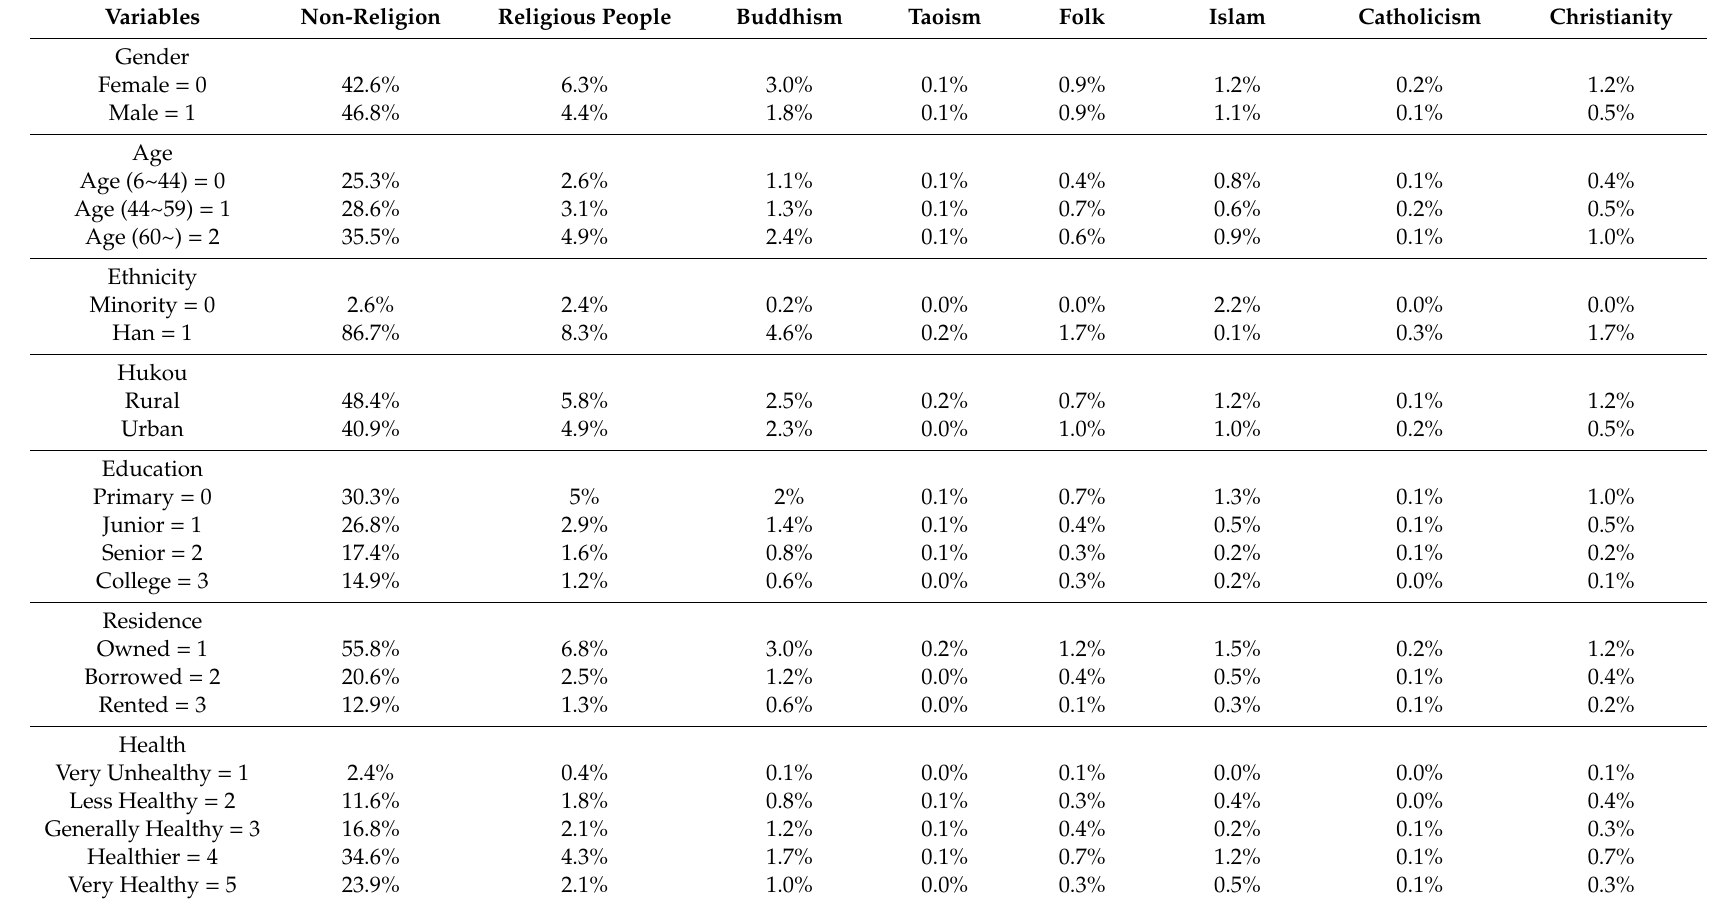
Table 1. The result of descriptive analysis (mean /